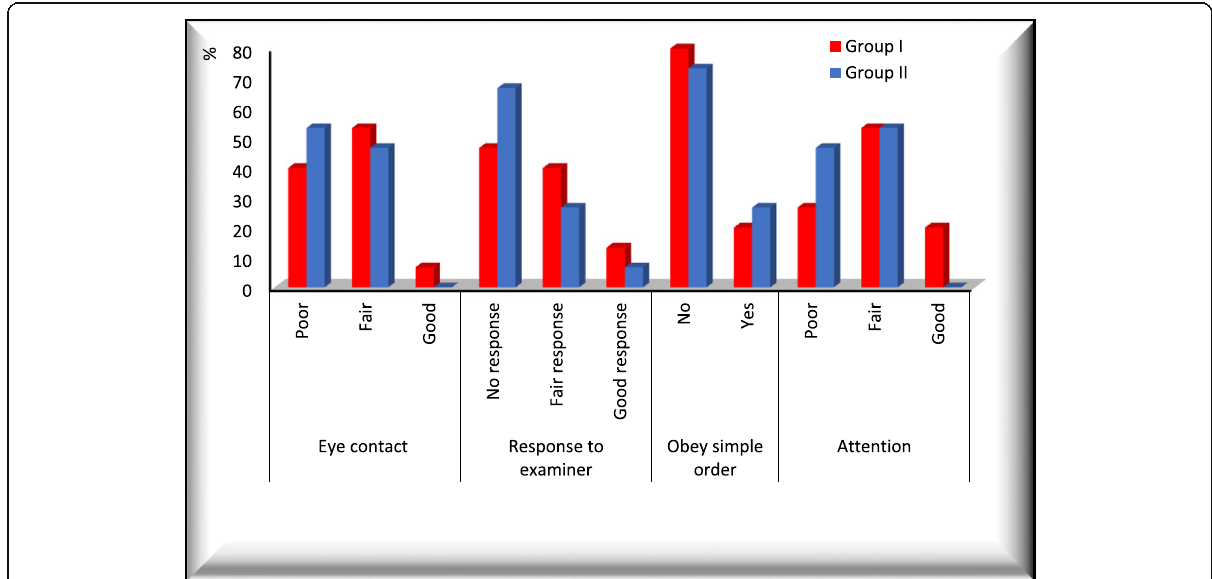
Fig. 1 Comparison between the two groups as regard baseline clinical